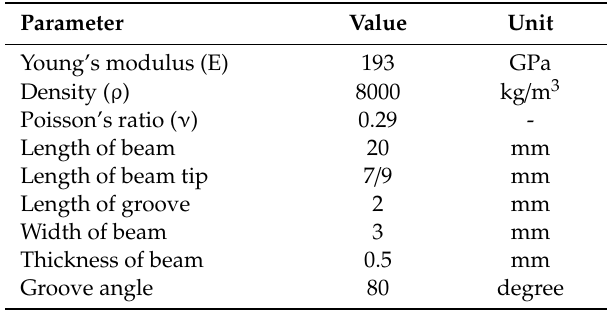
Table 1. Physical parameters of the actuator beam and material